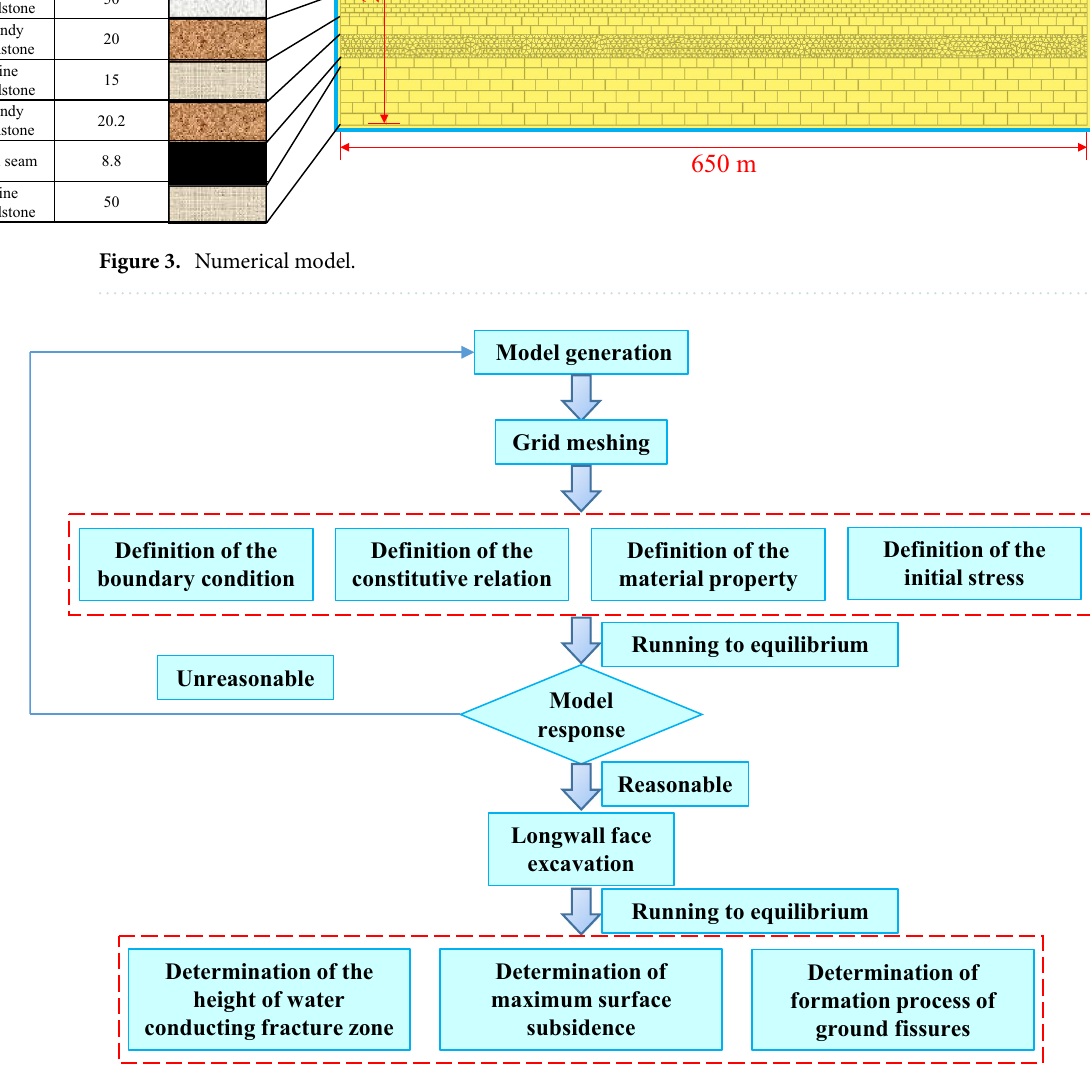
Figure 4. The flow chart of modeling